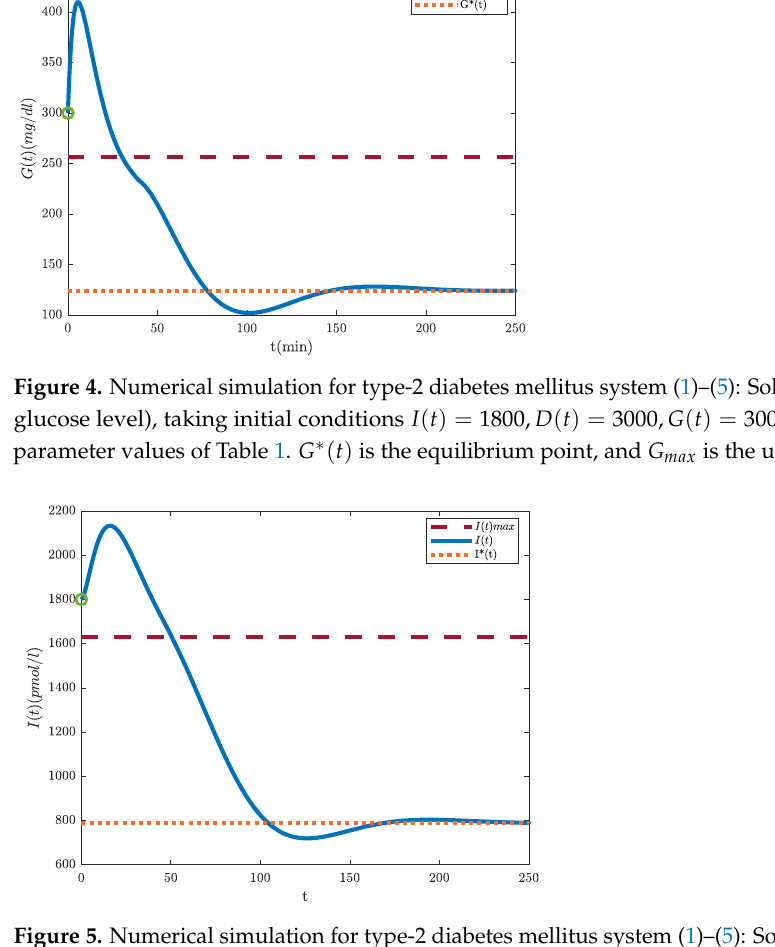
Figure 5. Numerical simulation for type-2 diabetes mellitus system (1)–(5): Solution for I ( t ) (plasma insulin variation), taking initial conditions I ( t ) = 1800, D ( t ) = 3000, G ( t ) = 300, and U ( t ) =